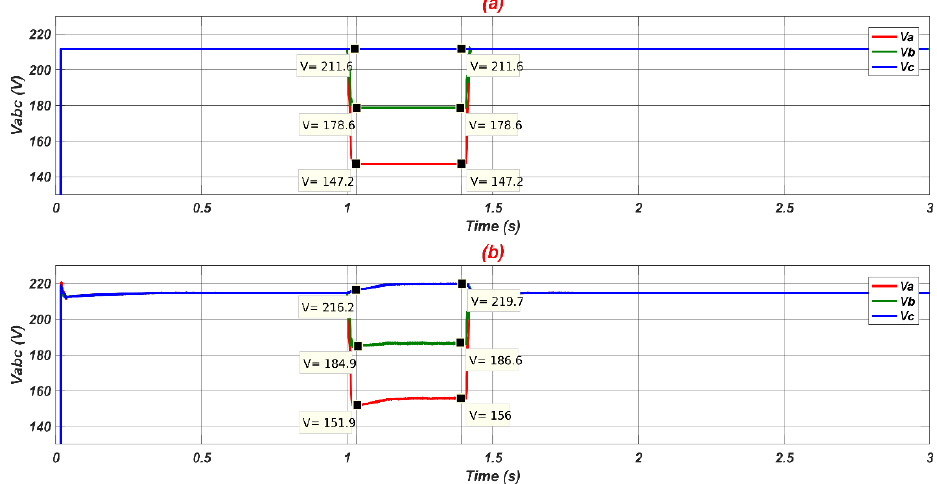
Figure 9. Phase voltages with system fault at ( a ) B_12 without DG, ( b ) GCPVS output terminal.